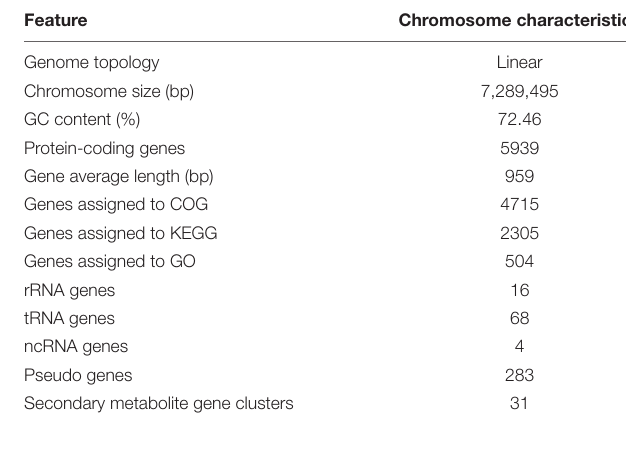
TABLE 3 | Genome features of strain HNM0039 T